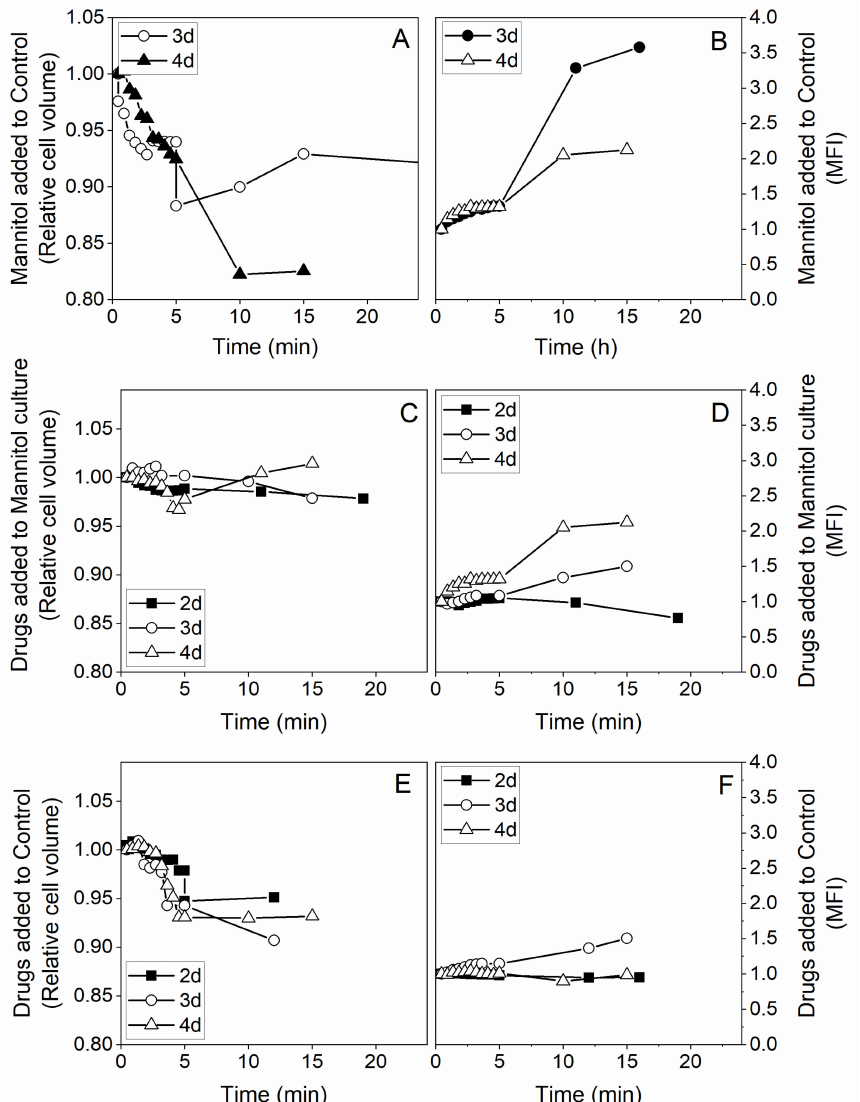
Figure 3. Early events for the effects of adding hyperosmotic culture conditions combined with lipoic acid and hydroxycitrate drugs. Relative cell volume and mean fluorescence intensity (MFI) monitoring for cells after two days of culture (filled squares), three days of culture (empty circles) and four days of culture (empty triangles). ( A ) Relative cell volume evolution upon addition of 200 mM final concentration of mannitol to cell culture. ( B ) MFI of mitochondrial staining with rhodamine 123 upon mannitol addition to cell culture. ( C ) Relative cell volume for mannitol and combination of ALA and HCA drugs. ( D ) MFI monitoring of drugs and mannitol cultures. ( E ) Relative cell volume variation upon ALA and HCA drugs addition to cell cultures. ( F ) MFI monitoring after drugs addition to control condition. All the figure values are relative units as described in the main